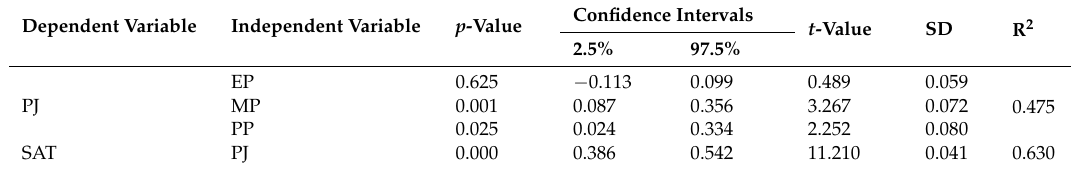
Table 6. Structural model